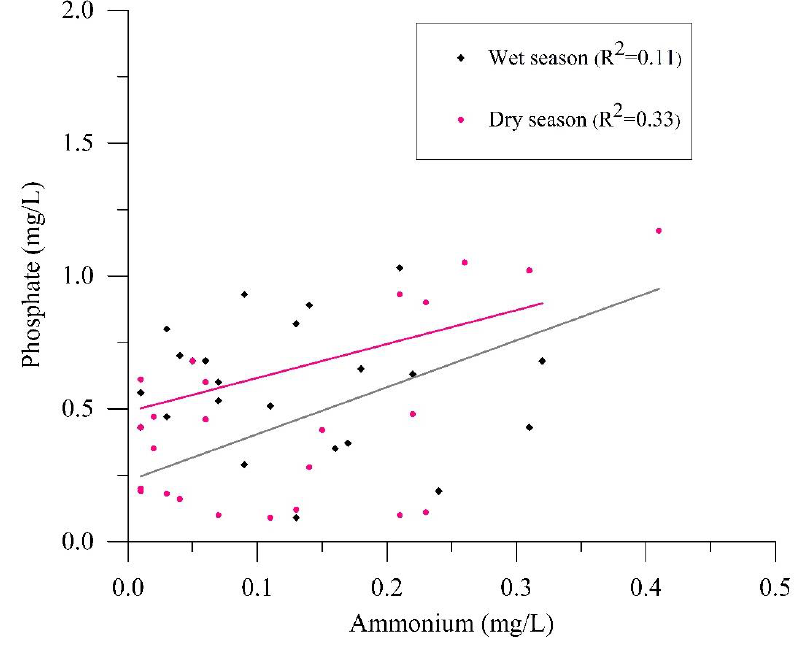
Figure 7. Relationship between phosphate and ammonium.